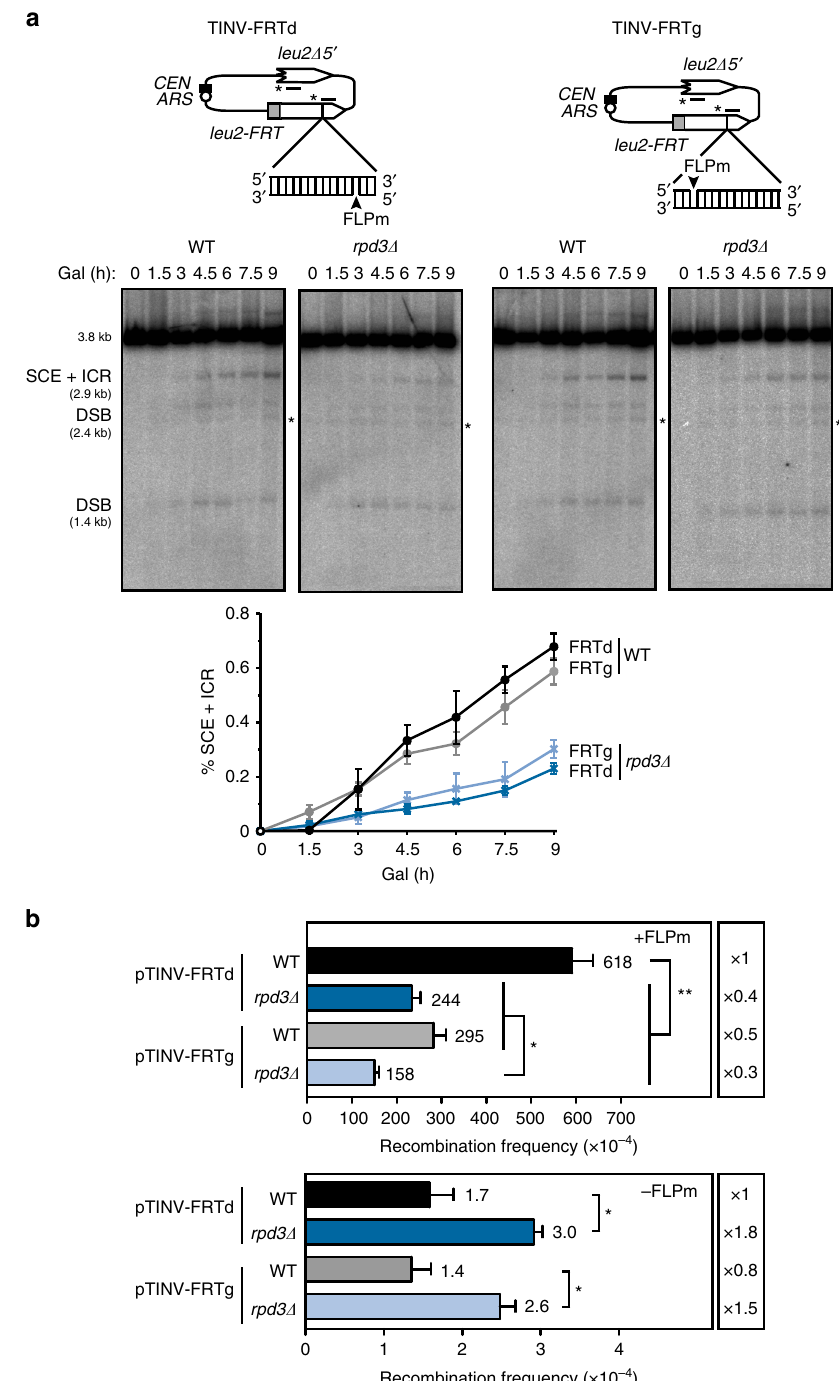
Fig. 5 Similar ef fi ciency of SCR at the leading and lagging strands. a Representative Southern blots and quanti fi cation of the 2.9-kb SCE + ICR fragments during a time-course experiment after FLPm induction in wild type (WFLP) and rpd3 Δ (WFRPD3) strains transformed with pTINV-FRTd or pTINV-FRTg ( n = 3). Schemes of the TINV-FRTd and TINV-FRTg systems are shown. Other details as in Fig. 4b. b Analysis of spontaneous ( − FLPm) and FLPm-induced ( + FLPm) recombination frequencies wild type (WFLP) and rpd3 Δ (WFRPD3) strains transformed with pTINV-FRTd or pTINV-FRTg ( n = 3). Means and SEM are plotted in all panels. In b , * p ≤ 0.05; ** p ≤ 0.01 (two-tailed Student ’ s t- test). See also Supplementary Fig. 3b. Data underlying this fi gure